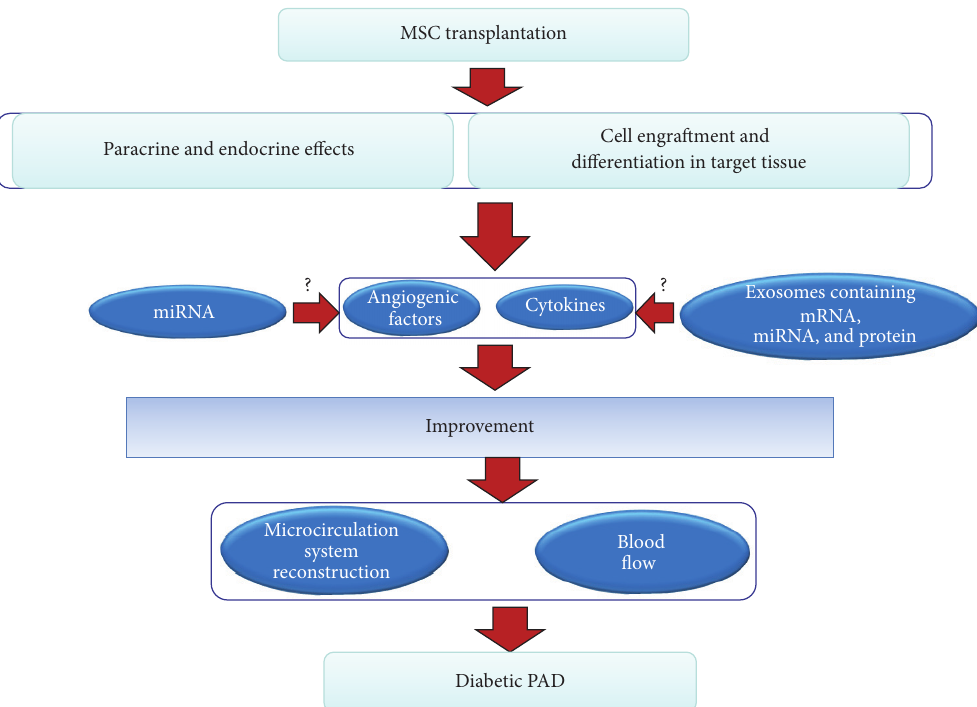
Figure 1: Mechanism of the effect of transplantation of MSCs on diabetic PAD. The mechanism of the recovery effect mediated by stem cell transplantation stems from two pathways: one is the secretion of angiogenic factors and cytokines and the other is the engraftment and differentiation of the cells into tissue constituents. Stem cells can specifically improve the local secretion and expression of angiogenic factors and cytokines, which contributes to the reconstruction of the microcirculation system and the improvement of blood flow and islet 𝛽 cell dysfunction, in turn leading to the improvement of diabetic PAD. Stem cells can also differentiate into endothelial cells to achieve recovery of endothelial cell dysfunction. These effects may be associated with miRNA and